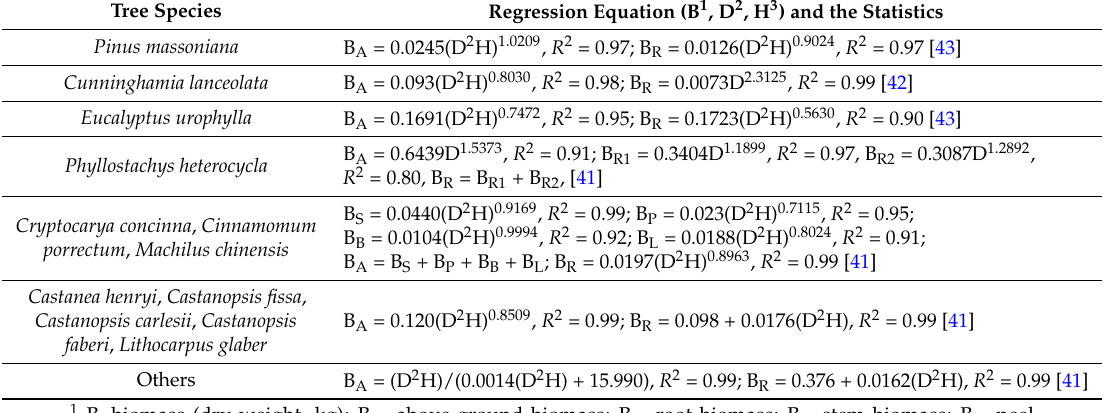
Table 2. Allometric biomass regression models for tree biomass calculations. Tree